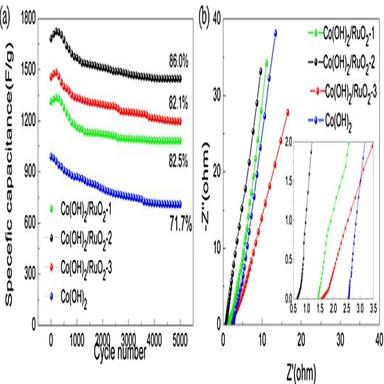
(a) Cycling performance of the Co(OH)2 and Co(OH)2/RuO2 composites at a current density of 5 A g−1 ; (b) Nyquist plots of the Co(OH)2 and Co(OH)2/RuO2 composites and (inset) its corresponding magnified part of the high-frequency region.